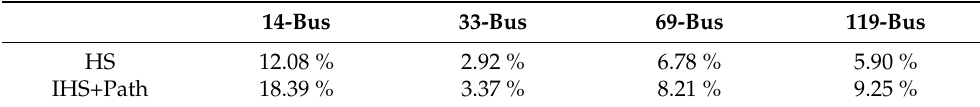
Table 6. Convergence analysis results for the 119-bus test